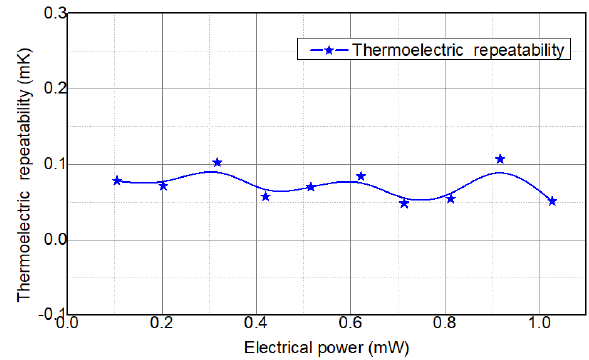
Figure 6. Thermoelectric repeatability of blackbody cavity.